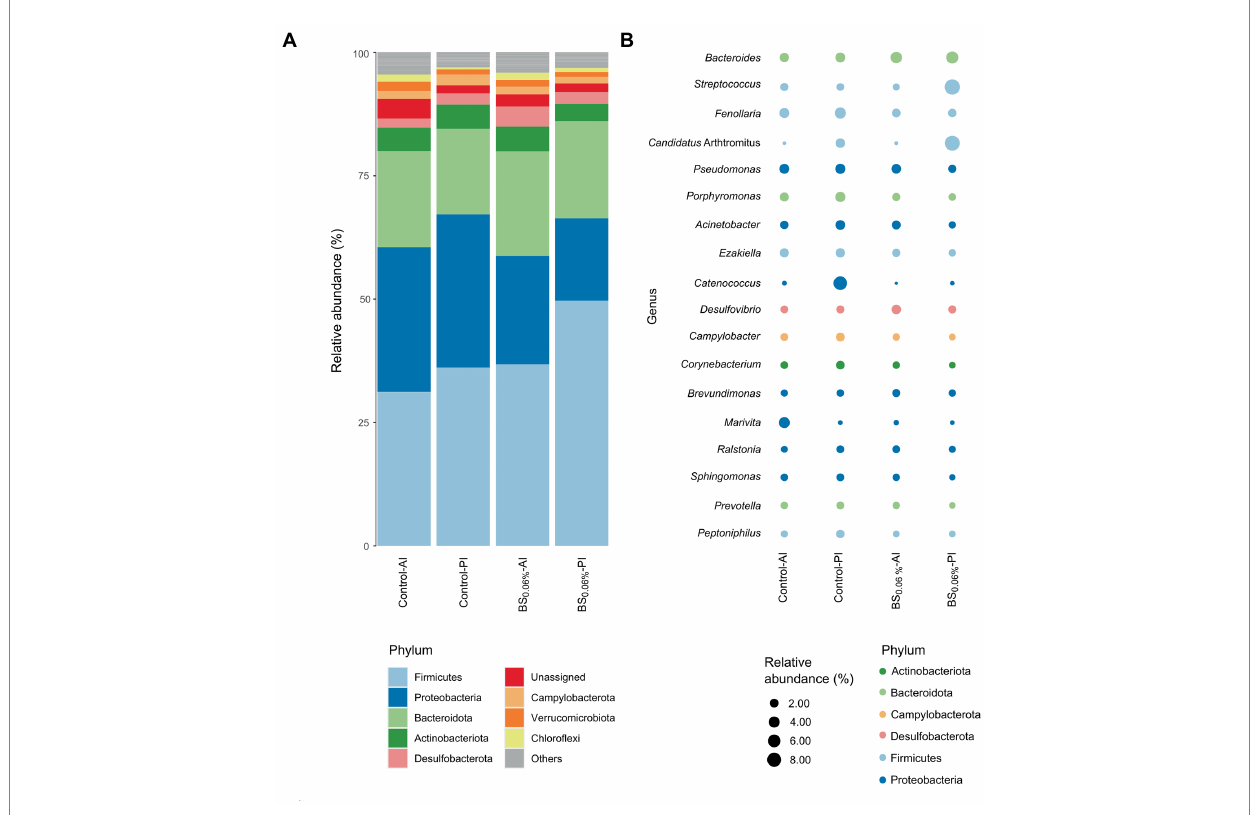
FIGURE 3 Relative abundances of gut bacterial taxa from gilthead seabream ( Sparus aurata ). Data are expressed at phylum (A) and genus (B) levels (excluding unassigned genera). Taxa appearance in the figures is in order of decreasing abundance (from bottom to top in the bar graph, and inversely in the bubble plot). Taxa with an abundance < 1% are classified as others in the bar graph and not represented in the bubble plot. Experimental groups ( n = 12 fish per group): anterior (Control-AI) and posterior intestine (Control-PI) of S. aurata fed the control diet, and anterior (BS 0.06% -AI) and posterior intestine (BS 0.06% -PI) of S. aurata fed a basal diet supplemented with a blend of bile salts at a dietary inclusion level of 0.06% (BS 0.06%